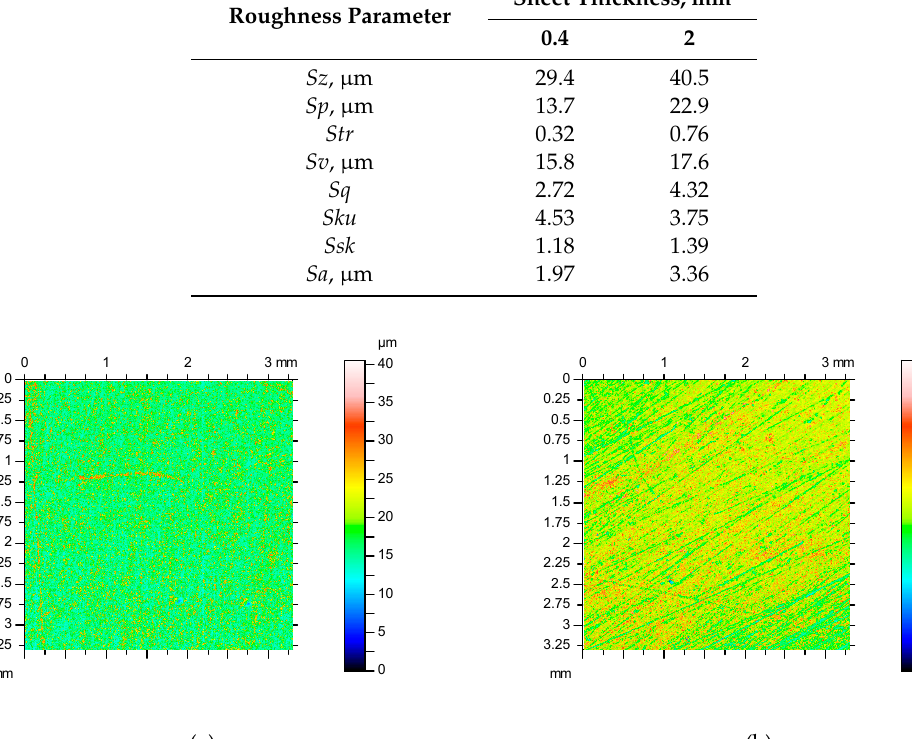
Figure 2. 2D profiles of measured sheets with thicknesses of ( a ) 2 mm and ( b ) 0.4 mm.